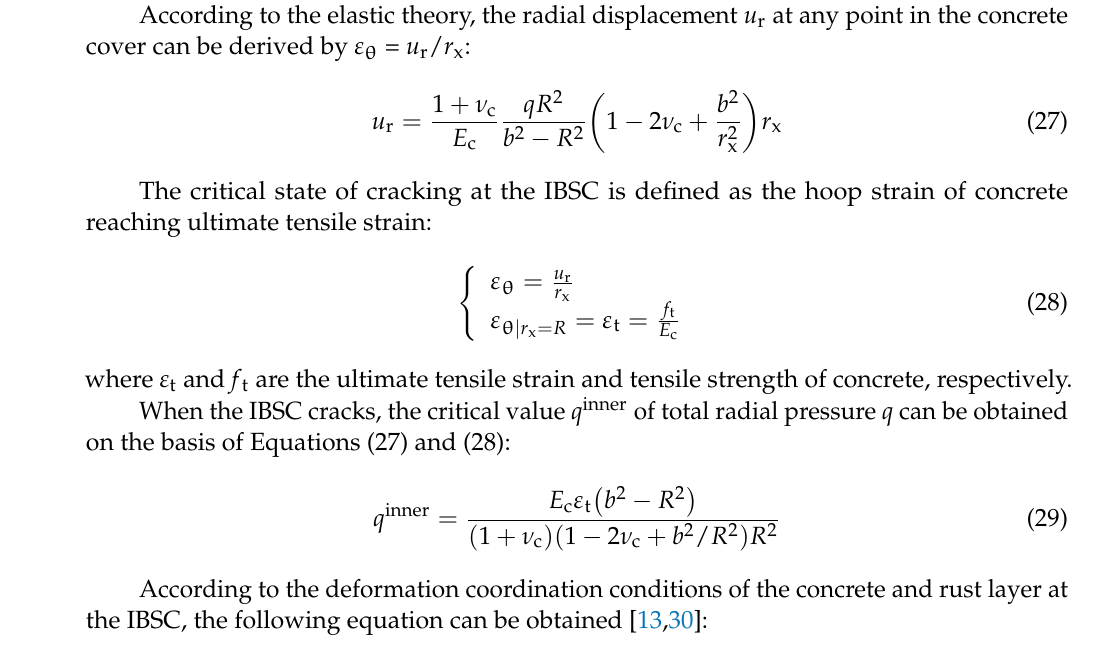
Figure 8. Radial deformations of concrete and rust layer at the IBSC under the total radial pressure in the non-cracking stage of the concrete cover.